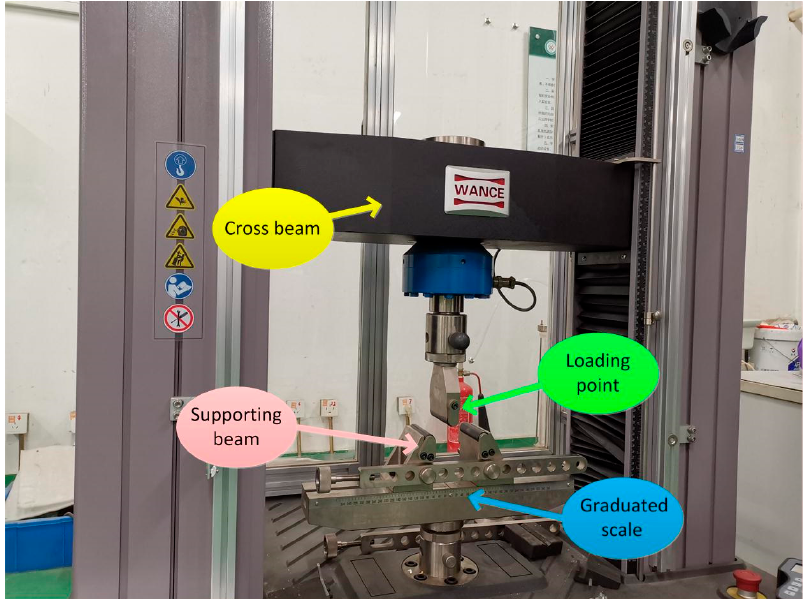
Figure 2. Three-point bending experimental setup.